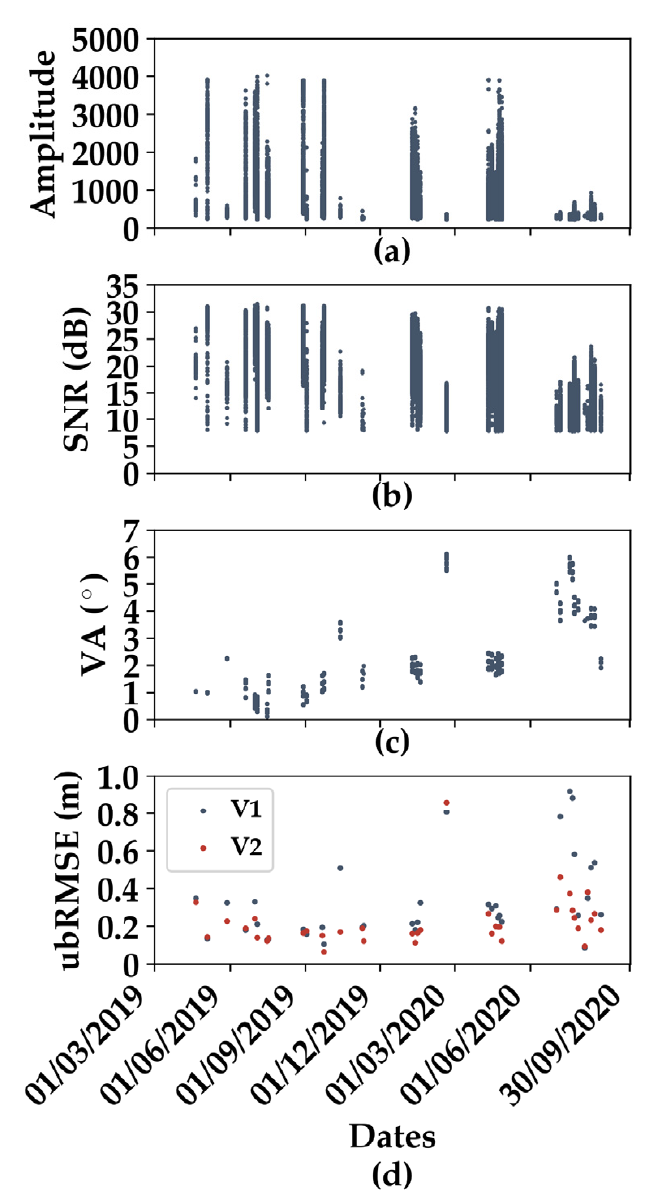
Figure 11. Distribution of amplitude ( a ), SNR ( b ), VA ( c ), and ubRMSE ( d ) for each acquisition date. Overall, the second release of the GEDI data products (V2) seemed to provide better elevation precision (lower ubRMSE) in comparison to V1 but lower accuracy (higher bias). For VA ≤ 3.5 ◦ , V1 provides slightly lower root mean squared errors in comparison to V2, which are 0.55 m and 0.60 m, respectively. The elevation accuracy provided by the coverage lasers or the full power lasers were also within the same magnitudes in V2 in comparison to V1, which showed more deviations according the acquiring beam. Therefore, in order to increase the accuracy (i.e., by decreasing the bias) of V1 and V2, we propose subtracting the observed mean differences between GEDI and the in situ elevations for V1 (bias of 34.7 cm) and V2 (bias of 54.4 cm). After subtracting the bias from V1 and V2, the results presented in Figure 12 show that on average, the reported elevations by V2 (RMSE = 27.0 cm, r = 0.66) were more accurate than those provided by V1 (RMSE = 42.7 cm, r = 0.34) for GEDI shots with VA ≤ 3.5 ◦